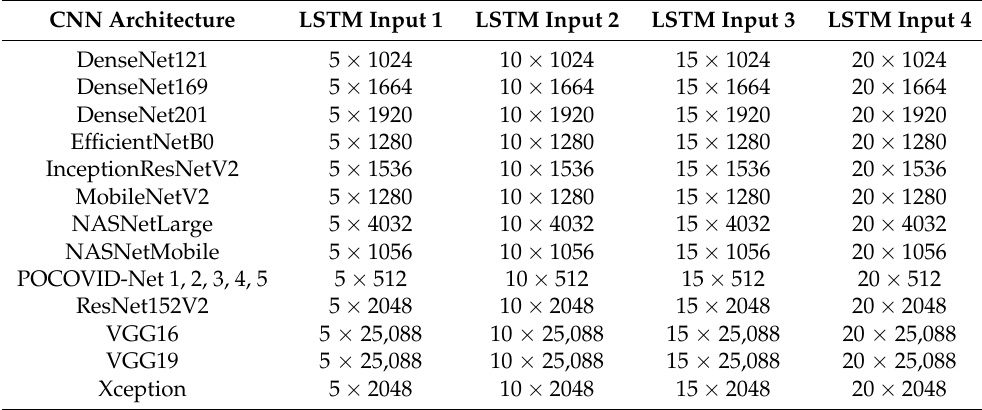
Table 6. Characteristics of used